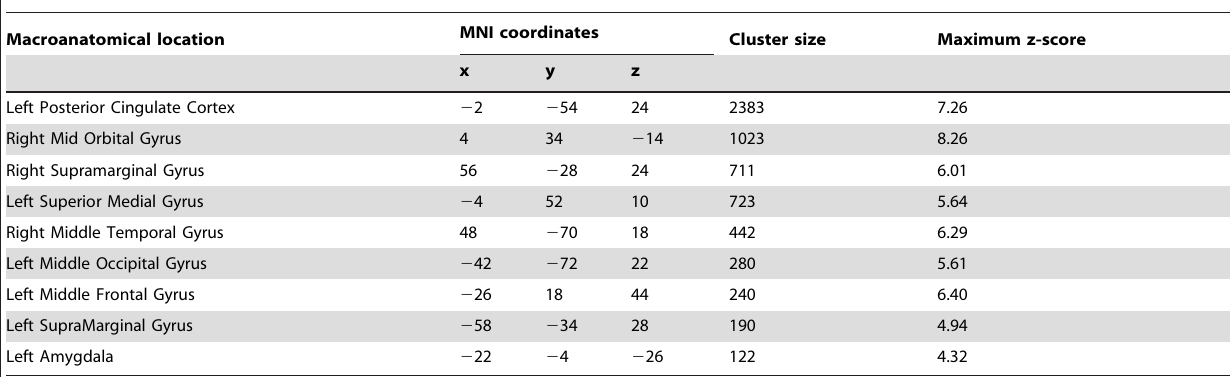
Table 3. Activation peaks of ALE meta-analysis of unconstrained cognition (DMN).